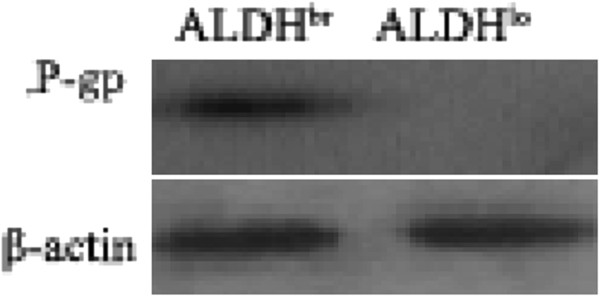
Western blot analysis demonstrated increased P-gp expression in 4T1 ALDHbr cells. The western blot analysis was performed as described in the Methods section. P-gp (141 kDa) expression was significantly increased in 4T1 ALDHbr cells compared with ALDHlo cells. β-actin served as the loading control. The experiment was performed in duplicate with similar findings obtained in each experiment. A representative blot is shown.